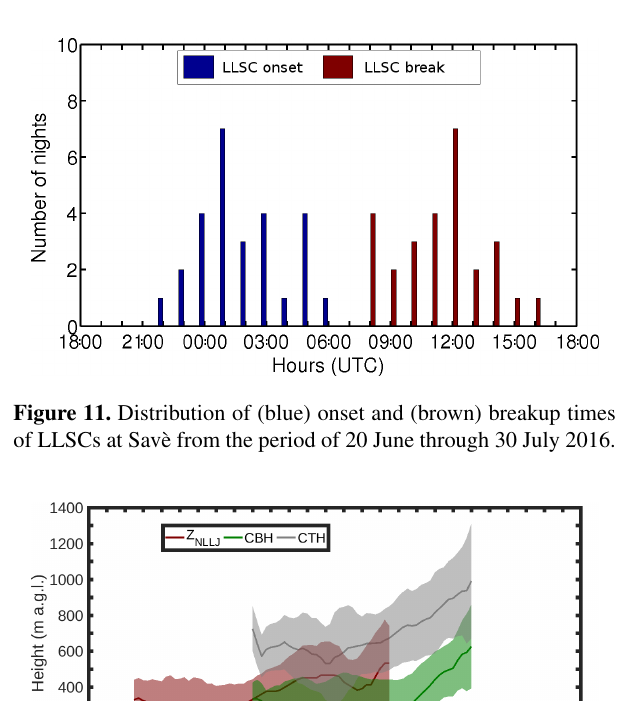
Figure 10. The time series of the onset (solid lines) and breakup times (dashed lines) of NLLJ and LLSCs are shown in black and blue, respectively. The red colored circles indicate the arrival time of the MI at Savè using the mean fuzzy logical function. Solid black vertical lines delimit the different phases of the monsoon described by Knippertz et al. (2017). Dashed vertical lines indicate the vortex phase included in the post-onset phase.